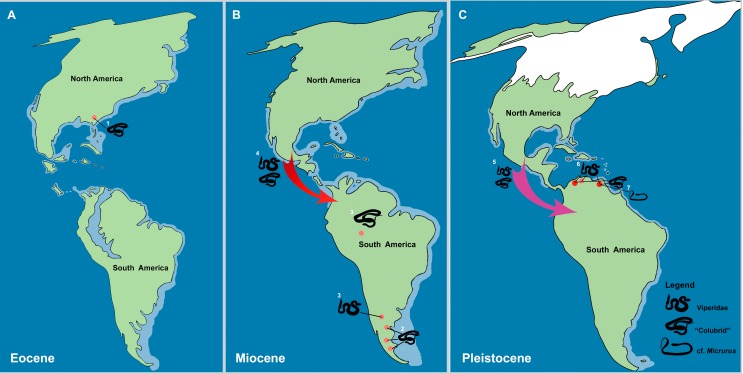
The historical biogeography of Colubroides (sensu Zaher et al., 2009) throughout the American continent during the Eocene to Pleistocene, based on the fossil record. (A) representative maps of Eocene; (B) Miocene; and (C) Pleistocene of America.(1) The oldest American “Colubridae” recorded from the late Eocene of Georgia, North America (Parmley & Holman, 2003); (2) “Colubridae” record from the early Miocene of Argentina, South America (Colhuehuiapianense South America Land Mammal Age, SALMA) (Albino, 1996); (3) Viperidae remains from the late Miocene of Cerro Azul Formation (Huayquerian SALMA), Argentina (Albino & Montalvo, 2006) and the “Colubridae” record from the late Miocene of Amazonia, Brazil (Hsiou & Albino, 2010); (4) First entrance of Colubroides from North America to South America by dispersion via Central American island complex during the Miocene (Hoffstetter, 1967; Cadle & Greene, 1993; Albino, 1996); (5) Second event of dispersion of Colubroides from North America to South America during the Plio/Pleistocene (Head, Sanchéz-Villagra & Aguilera, 2006); (6) Viperidae remains from Cucuruchu gravels, late Pleistocene of Venezuela (Head, Sanchéz-Villagra & Aguilera, 2006); and (7) The herein described record of cf. Micrurus (Elapoidea, Elapidae), which is the putative oldest South American record of Elapidae, supporting the hypothesis of establishment of the genus in the South American continent at least ∼2.1 Ma, after the complete uplift of the Panama Isthmus (Rage & Holman, 1984). Red arrows denote the first episode of dispersion and pink arrow denote the second event of dispersion. Palaeomaps based on the reconstructions from PALEOMAP Project (Scotese, 2010). (Drawing designed by Silvio Onary).